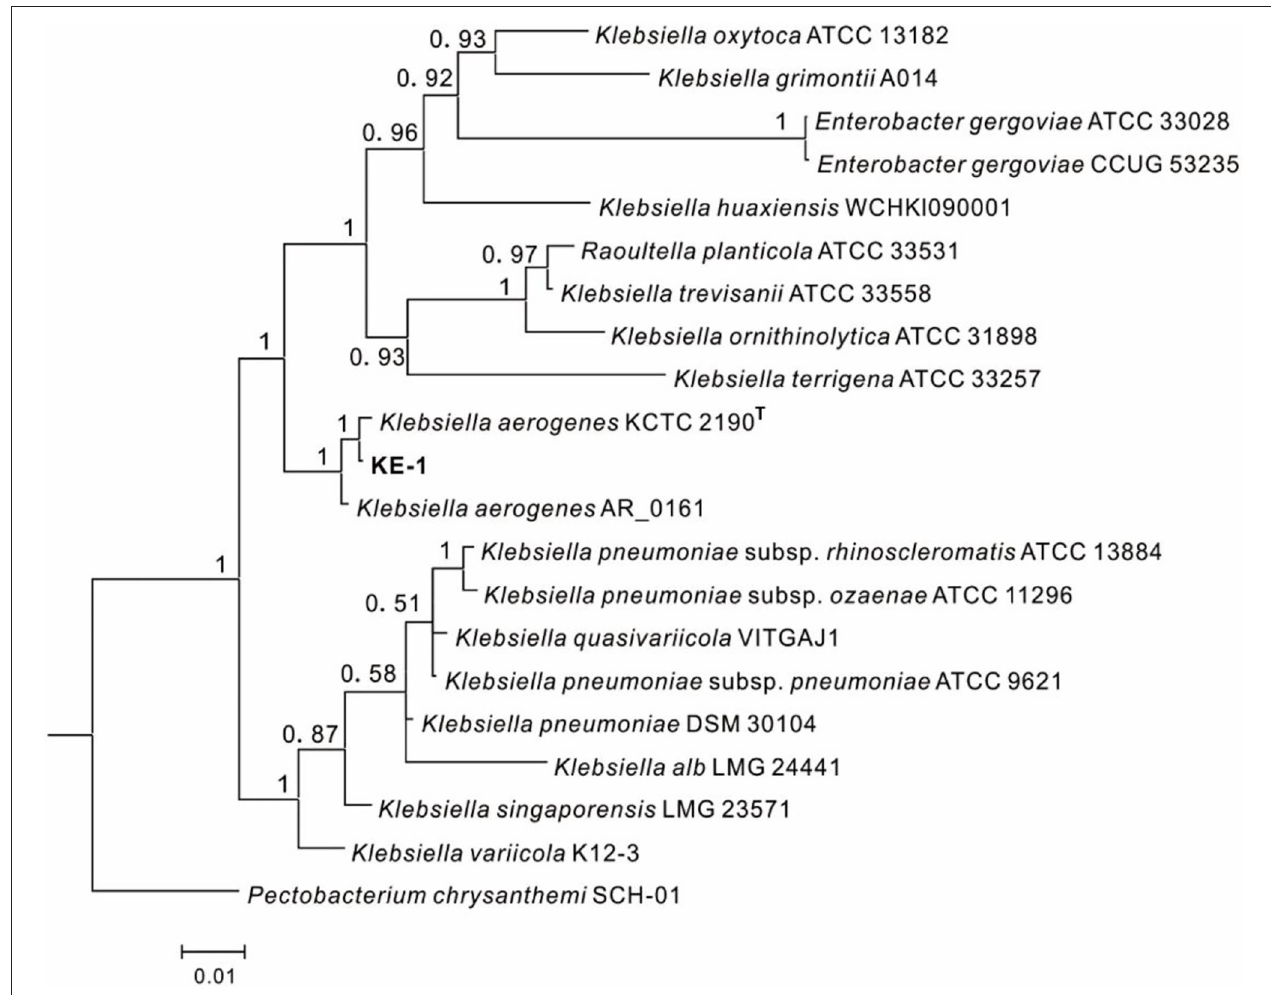
FIGURE 2 | Bayesian tree of endohyphal bacterium Klebsiella aerogenes KE-1 on the basis of three gene (16S rDNA, gyrB , and rpoB ) sequences. Bayesian posterior probabilities > 0.5 are given at the nodes. Examined strains are in bold. The out group is Pectobacterium chrysanthemi SCH-01.